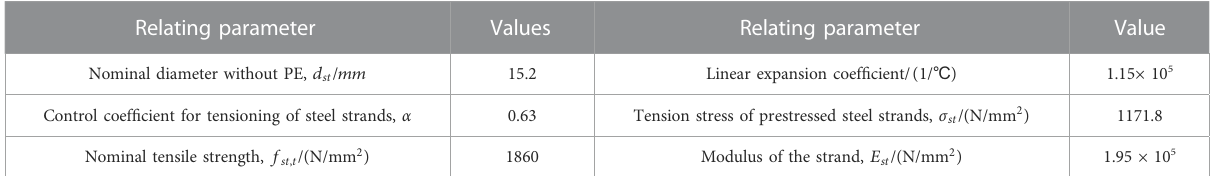
TABLE 2 Major parameters of the strand.